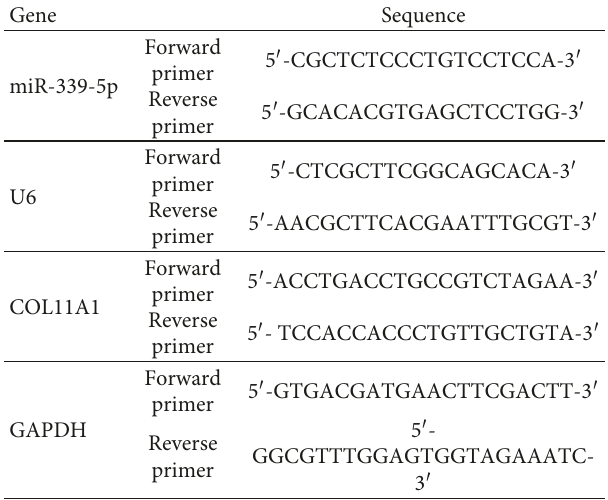
Table 1: qRT-PCR primer